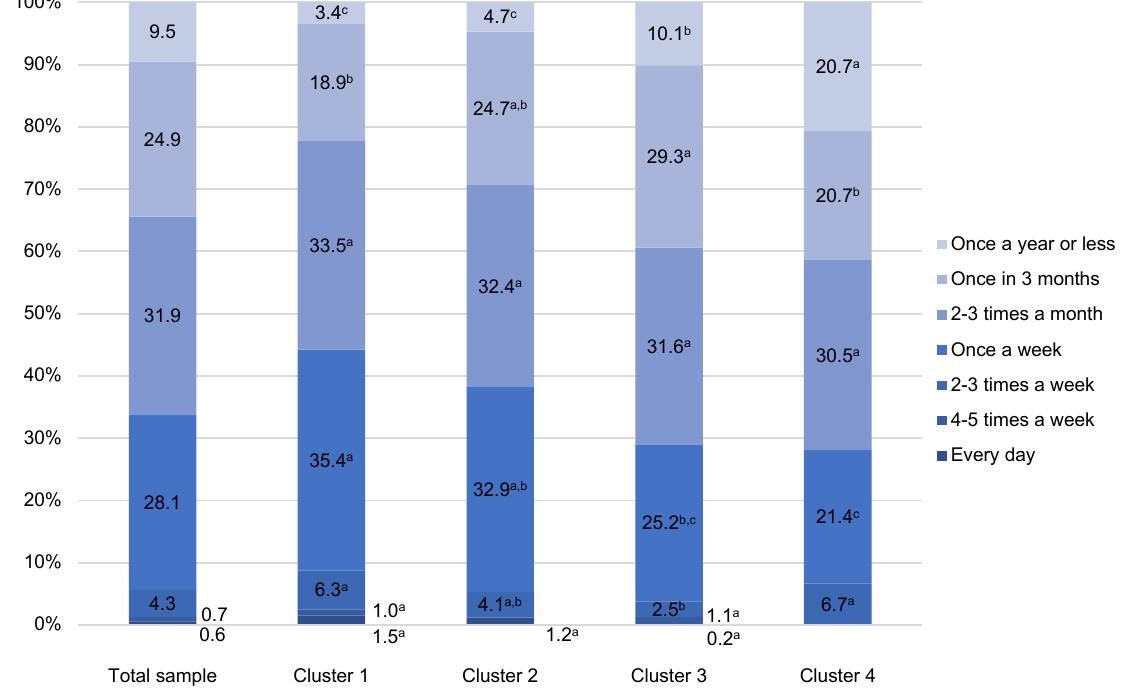
Figure 1. At-home white fish consumption of Croatian fishery consumers (n = 977). a–c Different letters in the same consumption frequency category indicate statistically significant differences ( p < 0.001).